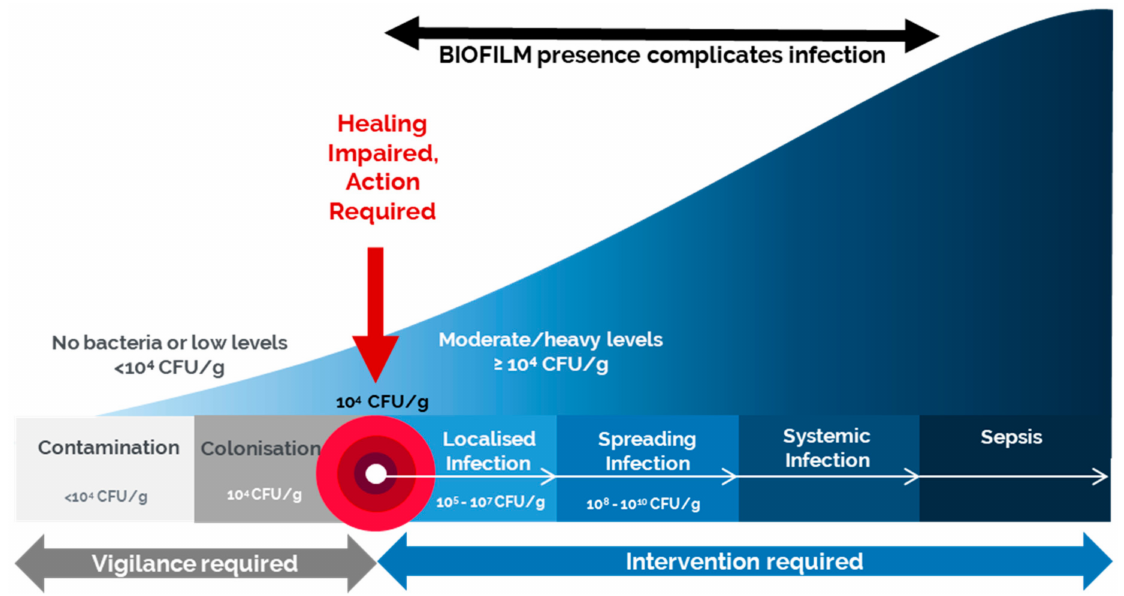
Figure 1. The Wound Infection Continuum. When wound bacterial loads exceed 10 4 CFU/g, intervention is required to address biofilm and prevent serious infection from occurring. (Modified from Woodmandsey and Roberts. Int Wound J